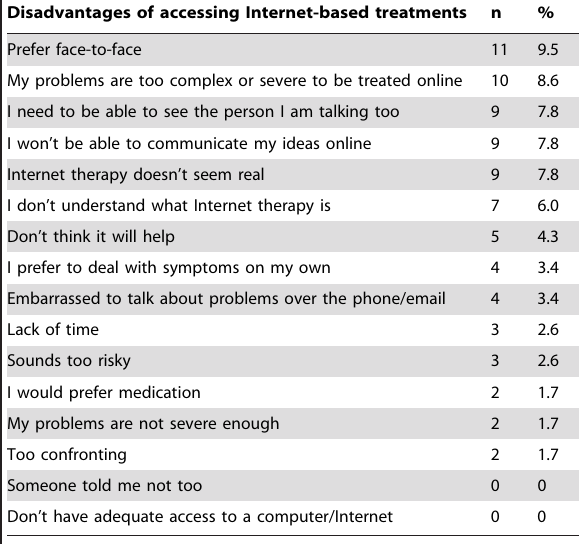
Table 3. Perceived disadvantages of accessing Internet- based treatments reported by the Internet Survey group (N=